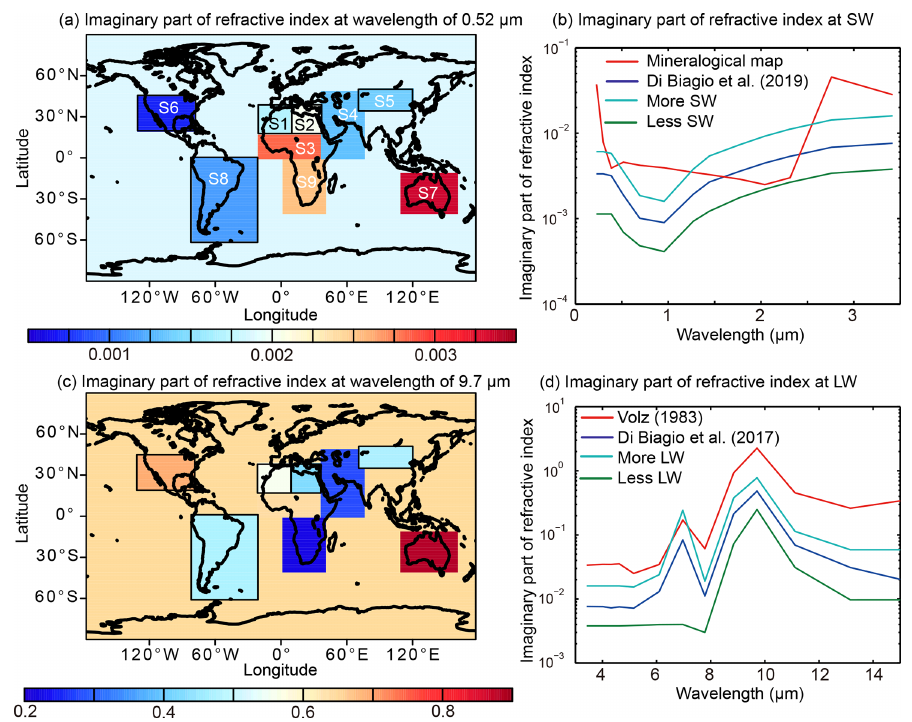
Figure 1. Imaginary part of the refractive index at (a) 0.52µm, (b) SW, (c) 9.7µm, and (d) LW. The refractive index obtained from 19 samples was aggregated into nine main source regions, and the arithmetic mean was calculated for each source region (Di Biagio et al., 2017, 2019). The global mean is used for others. The coordinates of the nine source regions were (S1) western North Africa (18–37.5 ◦ N,